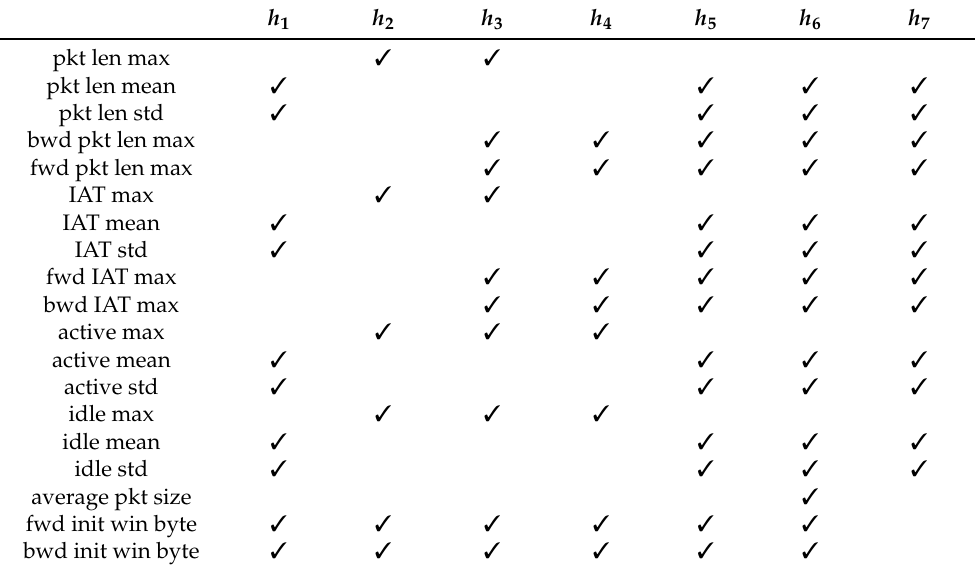
Table 4. Bidirectional flow-based features including some for forward and backward-flow only. h